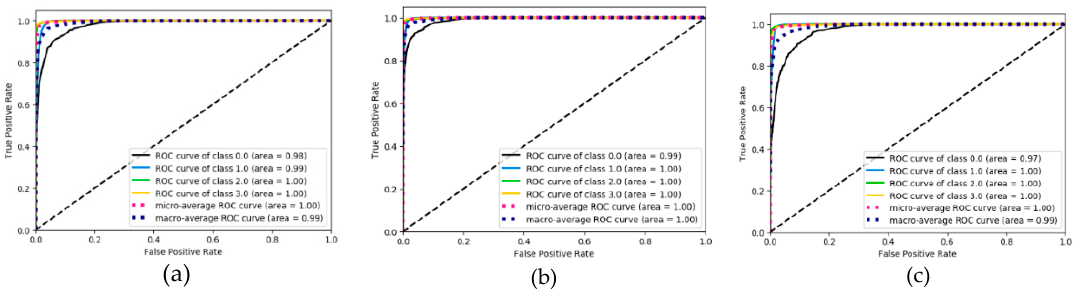
Figure 12. ROC curve performance derived from FMS-Net classification under three pace settings: 0.78 m/s ( a ), 1.0 m/s ( b ) and 1.25 m/s classes ( c ).